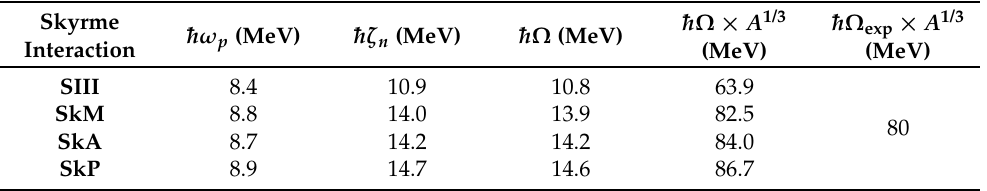
Table 1. Giant dipole fundamental mode, plasma frequency, and energy of the GDR fundamental overtone for various Skyrme